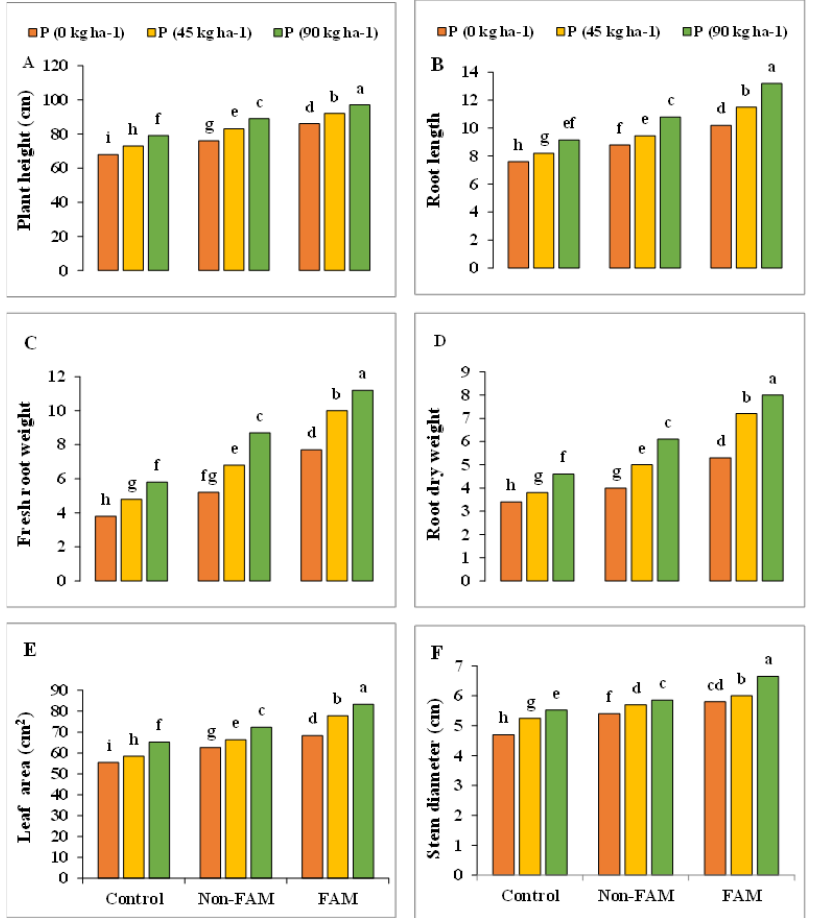
Figure 1. Combined use of fermented/non-fermented animal manure and phosphorus fertilizer on the growth parameters of wheat. ( A ) plant height, ( B ) root length, ( C , D ) root fresh and dry weight, ( E ) leaf area and ( F ) stem diameter. Columns with different letters are significantly different from one another at a level of significance of p < 5%. The combined application of fermented animal manure and a full dose of P fertilizer showed a 83.33 cm 2 leaf area, followed by treatment with fermented manure and a half dose (45 kg·ha −1 ) of P fertilizer. The non-fermented manure also showed a significant in- crease in leaf area as compared with the untreated control (Figure 1). Likewise, the maxi- mum stem diameter (6.65 mm 2 ) was obtained by the combined use of fermented manure and the recommended rate of P fertilizer. Similarly, the total number of tillers (14) and fertile tillers per pot (12) were at their maximums in the treatment where the combination of fermented animal manure and the recommended rate of P fertilizer were applied (Fig- ure 2). Non-fermented manure along with both levels of P fertilizer addition showed a significant response regarding tiller count compared with the control. The mean highest